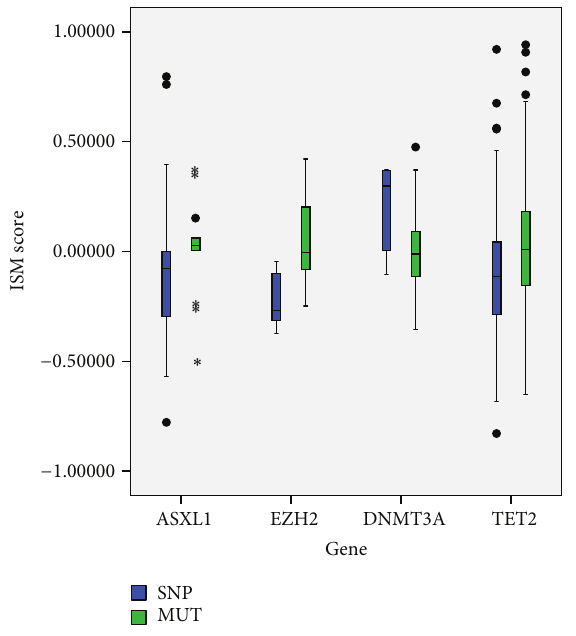
Figure 4: Distribution of ISM